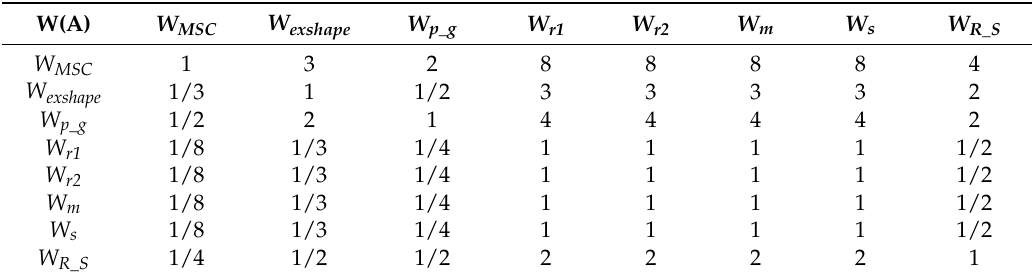
Table 10. Similarity index of the relative weight of the 8-order